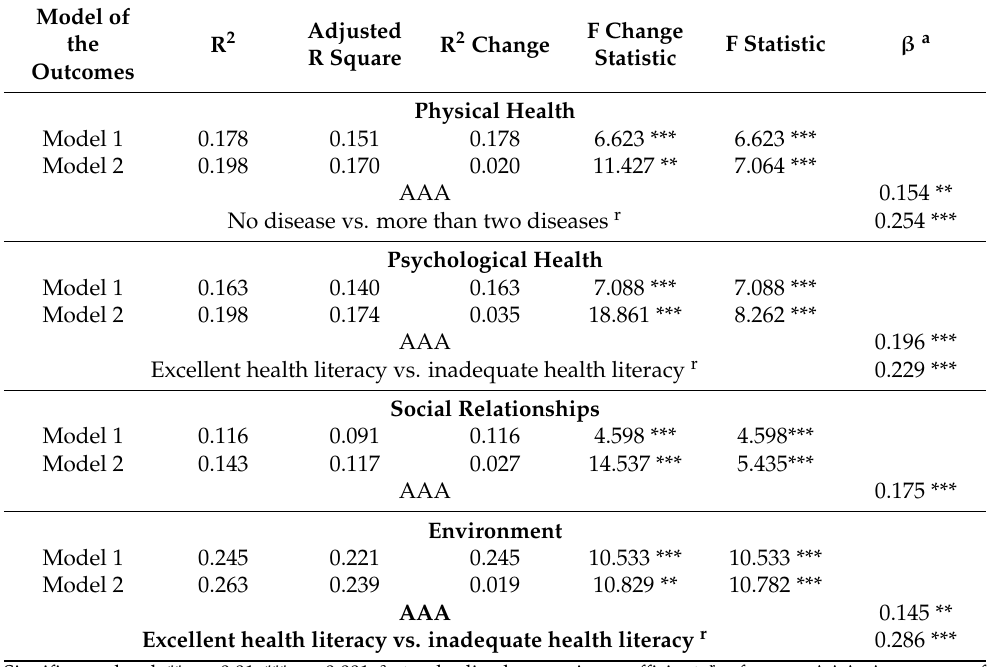
Table 4. The Hierarchical Multiple Regression of AAAQ on QOL in Four Domains after Controlling for Other